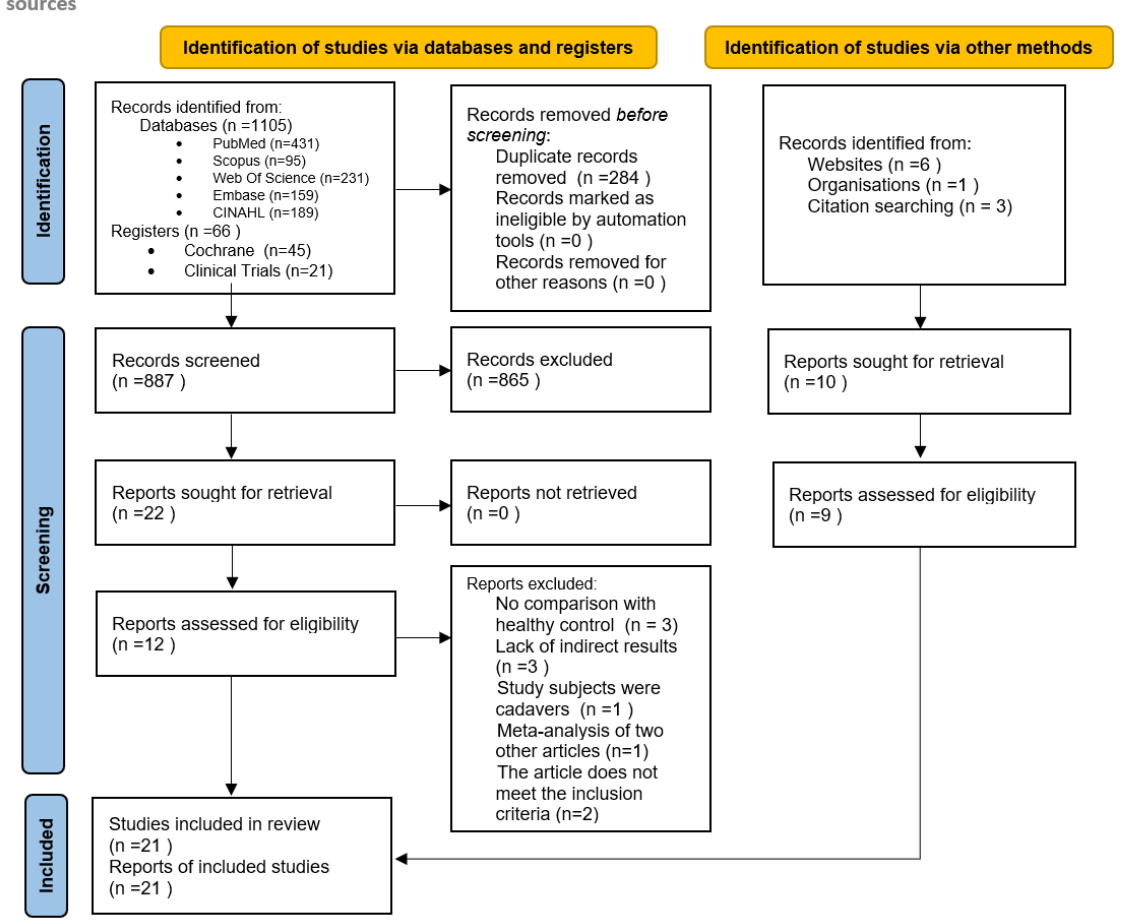
Figure 1. Flowchart of literature search according to Preferred Reporting Items for Systematic Re- views and Meta-Analyses